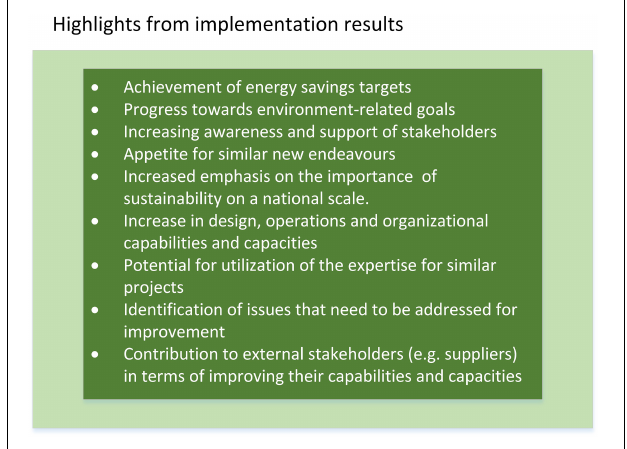
FIGURE 4 | Highlights from implementation results of the Sustainable Energy Action Plan